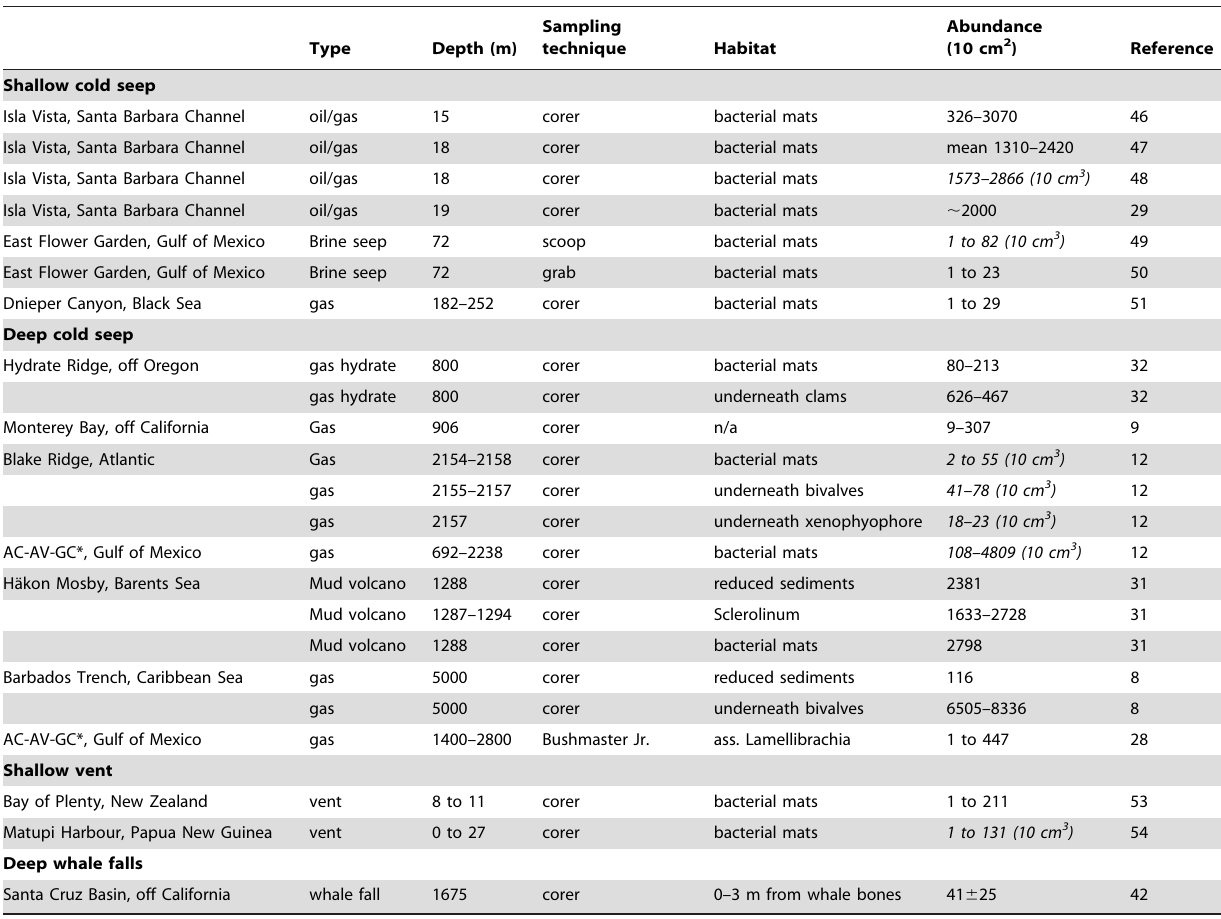
Table 1. Meiofauna at seeps and